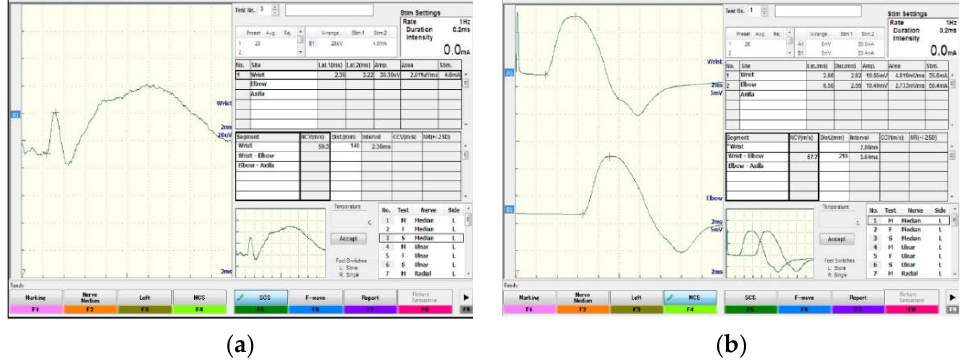
Figure 2. Nerve conduction for CTS patients ( a ) abnormal ( b ) normal.